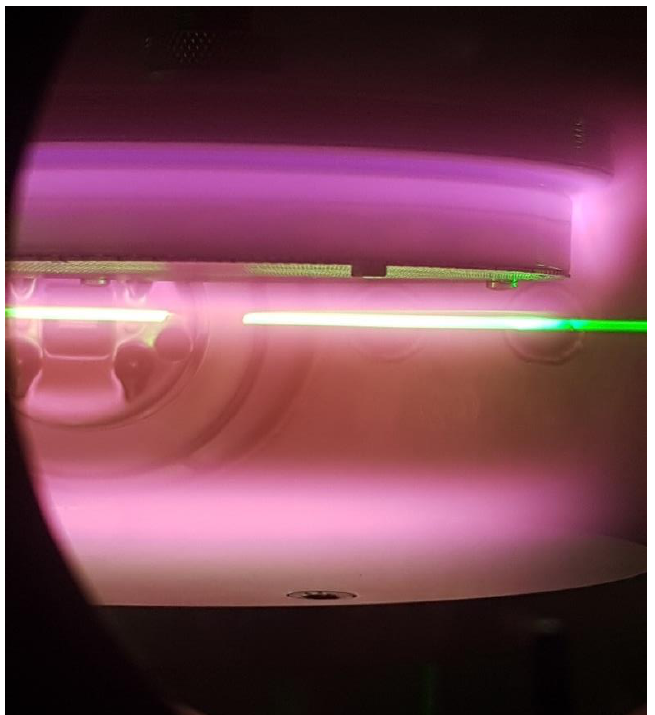
Figure 5. Appearance of tholins in the N 2 – CH 4 plasma, diffusing a laser light of wavelength 532 nm, during experiments carried out with the PAMPRE reactor.